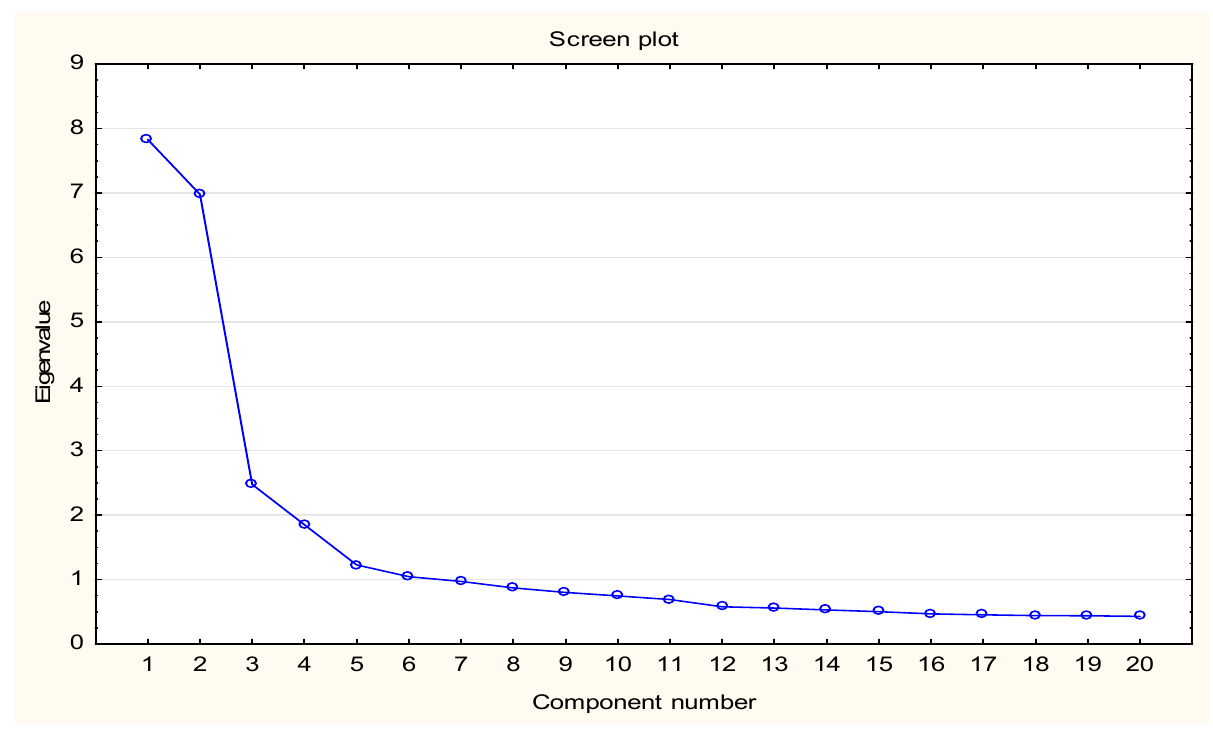
Figure 1. Scree plot of the three-factor MAS-PL structure.